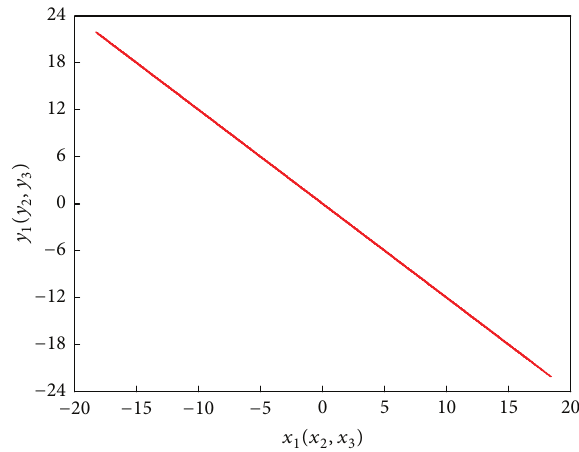
Figure 9: Synchronization behavior of the Lorenz system and the L¨u system with the scaling factor 𝜅 = −1.2